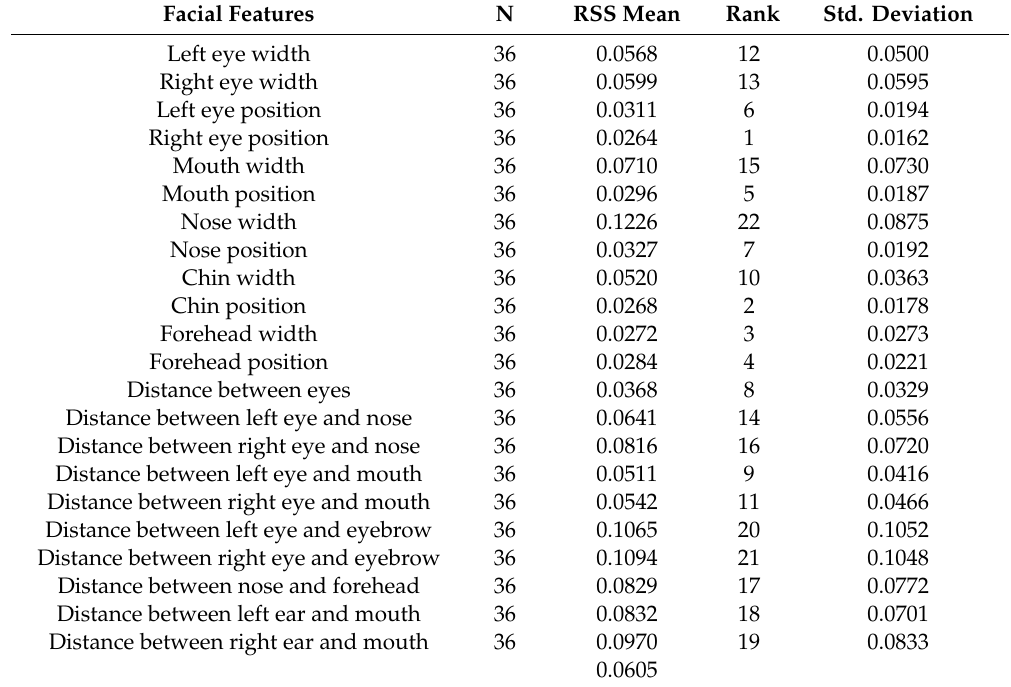
Table 4. The RSS means between sad expression and neutral mode of 22 facial features for 36 subjects. Facial